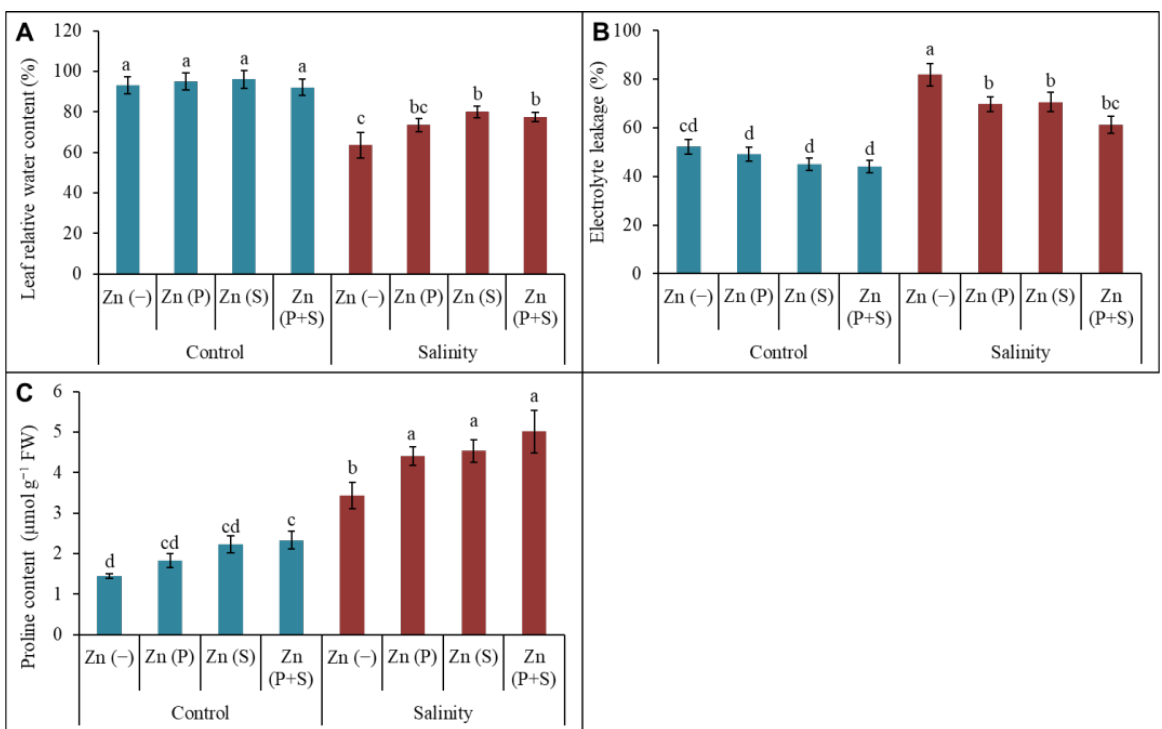
Figure 3. Leaf relative water content ( A ), electrolyte leakage ( B ), and Pro content ( C ) of soybean plants induced by Zn supplementation. Twenty five-day-old plants were subjected to salt (150 mM NaCl) and supplemented with Zn (1 mM ZnSO 4 · 7H 2 O). P and S indicate seed priming and foliar application with Zn, respectively. Control treatments were grown with water. Mean ( ± SD) was calculated from three replicates for each treatment. Different letters of bars indicate significant differences at p ≤ 0.05 applying Tukey’s HSD